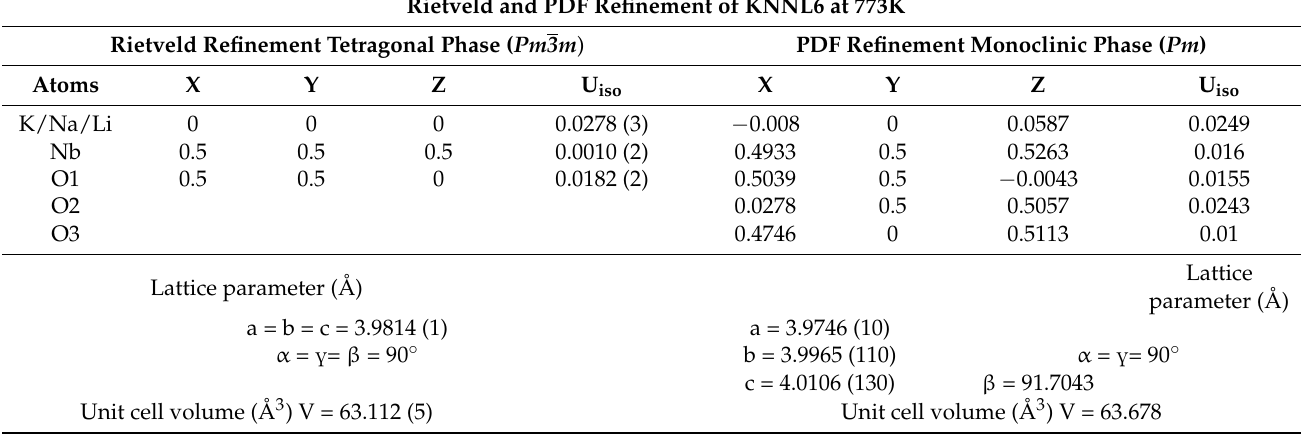
Table 1. Structural parameters, fractional atomic coordinates, and equivalent isotropic displacement parameters ( U iso in Å 2 ) from the Rietveld refinement and PDF fit (1.7–10 Å) results of neutron data of KNNL6 at various temperatures. Rietveld and PDF Refinement of KNNL6 at 773K Rietveld Refinement Tetragonal Phase ( Pm3m